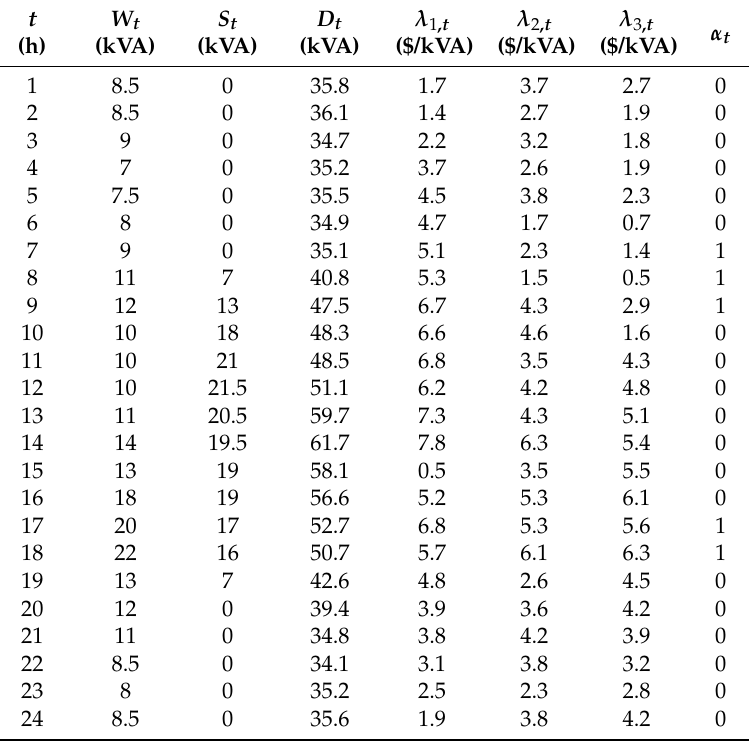
Table 3. Input values for each study period in the analysis